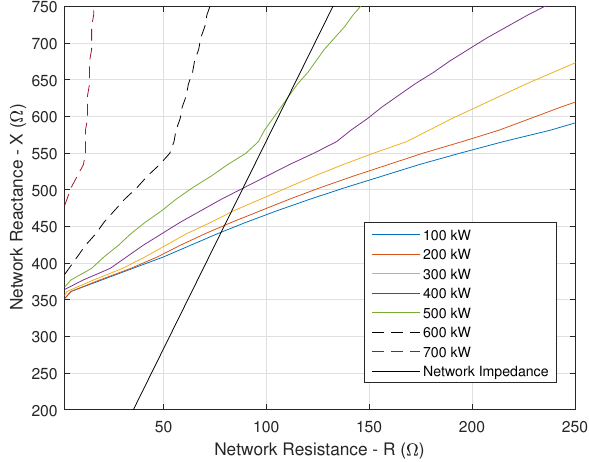
Figure 9. Stability limit curve of traction chain in the network reactance ( X ) and resistant ( R ) complex plane. Different levels of power